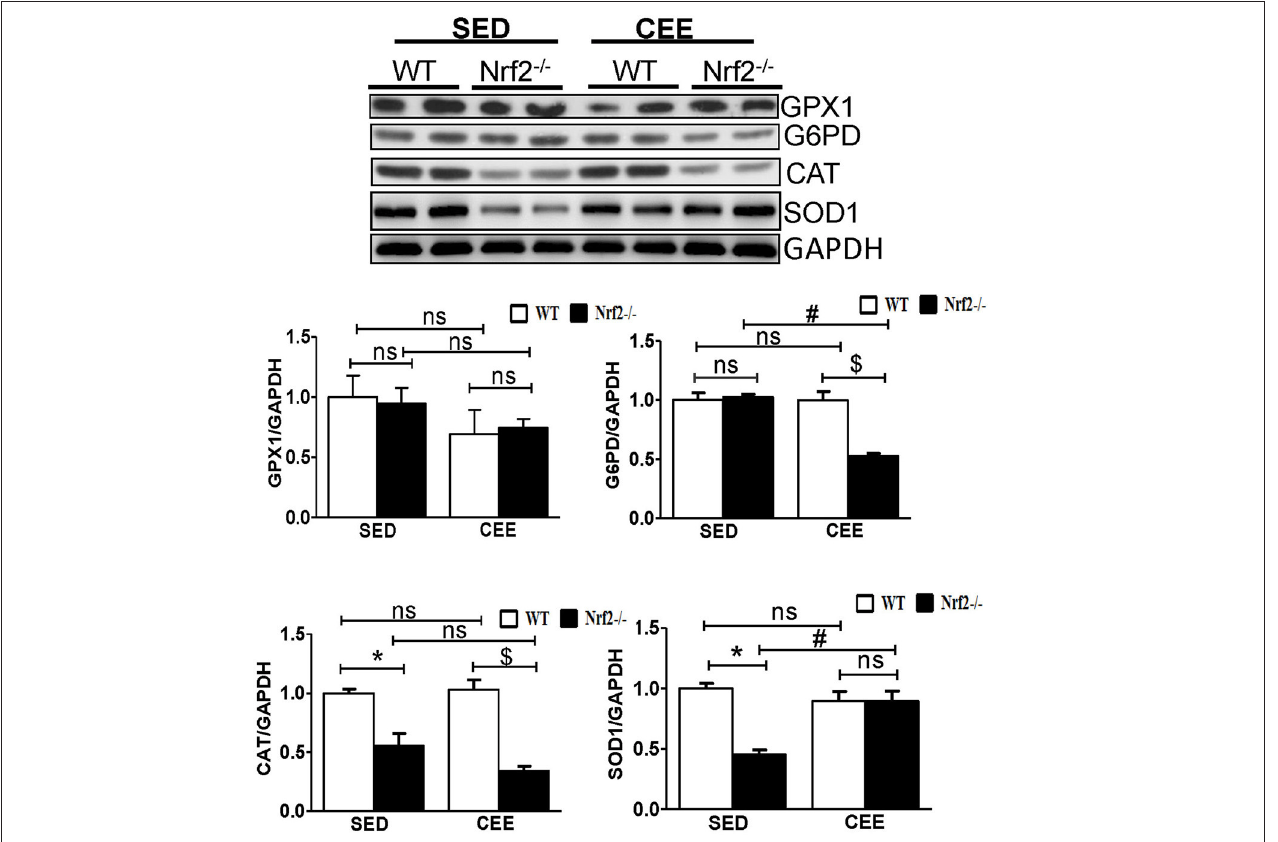
FIGURE 2 | Dysregulation of Antioxidant proteins in response to chronic endurance exercise in aged Nrf2 − / − mice hearts. Antioxidant protein expression (GPX1, CAT, G6PD, and SOD1) were determined using immunoblotting with specific antibodies. The relative intensity signals were quantified using ImageJ software and normalized to GAPDH intensity and represented as histogram. Experiments were analyzed using one way ANOVA followed by Tukey multiple comparison tests and differences between the means were considered statistically significant if P < 0.05 (* vs. WT-SED, # vs. Nrf2 − / − -SED, $ vs. WT